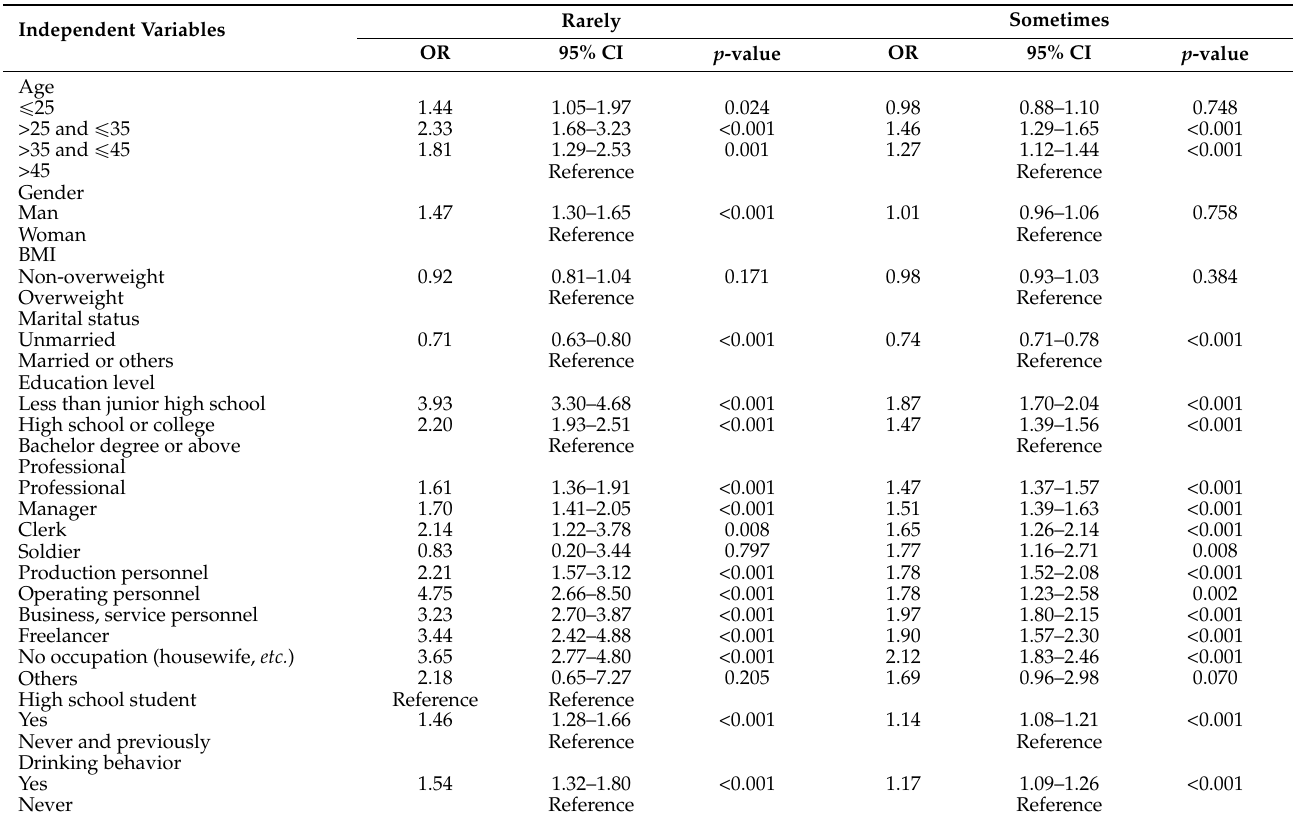
Table 2. Odds ratios pertaining to poor work-recreation balance conditions for demographic characteristics via multinomial logistic regression modeling. Independent